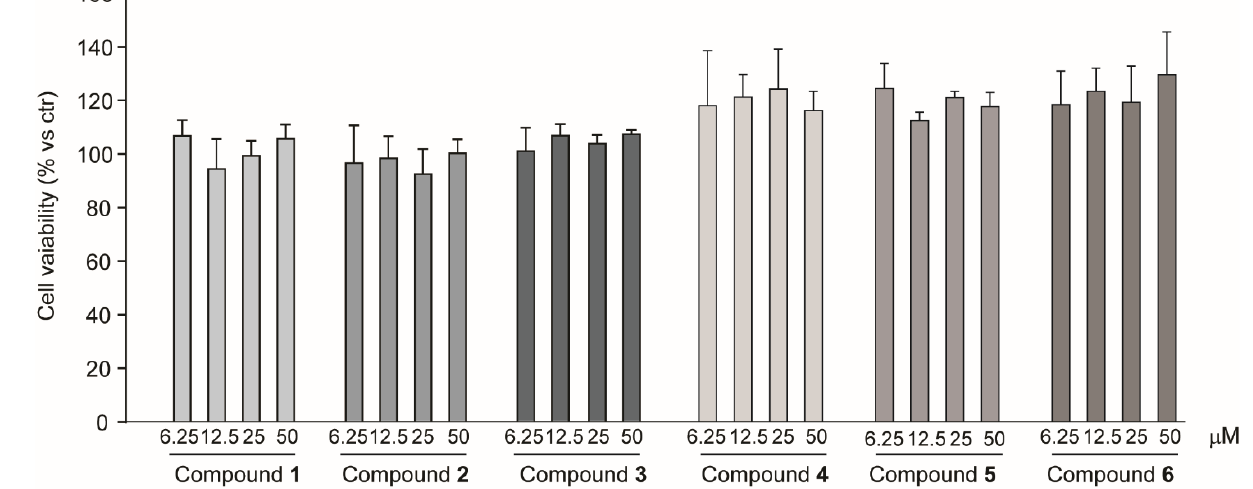
Figure 4. Cytotoxicity effect of compounds isolated from R. michauxii in Huh7 cell line. Cells were seeded (8000/well of 96 well tray) and incubated with DMEM supplemented with 10% FCS; 24 h later the medium was replaced with one containing 10% FCS and the reported concentrations of compounds and the incubation was continued for an additional 72 h. At the end of this incubation period the cell viability was determined by the SRB assay. Each bar represents the mean ± SD of three independent experiments.